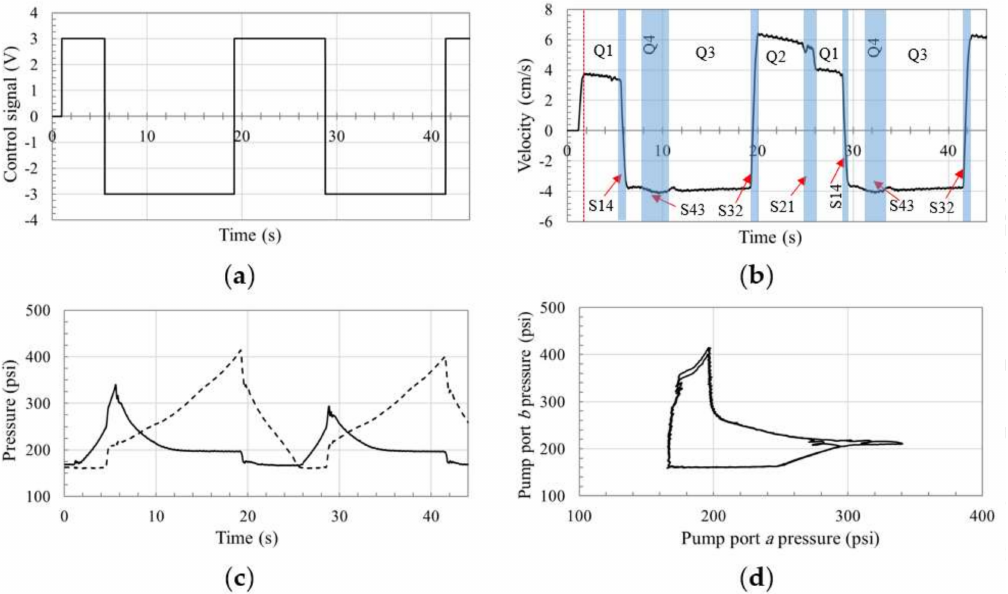
Figure 14. Performance of circuit using SQVs for a 41 kg attached mass: ( a ) control signal; ( b ) actuator velocity; ( c ) pressures at the pump ports a (solid line) and b (dotted line); ( d ) pump pressure